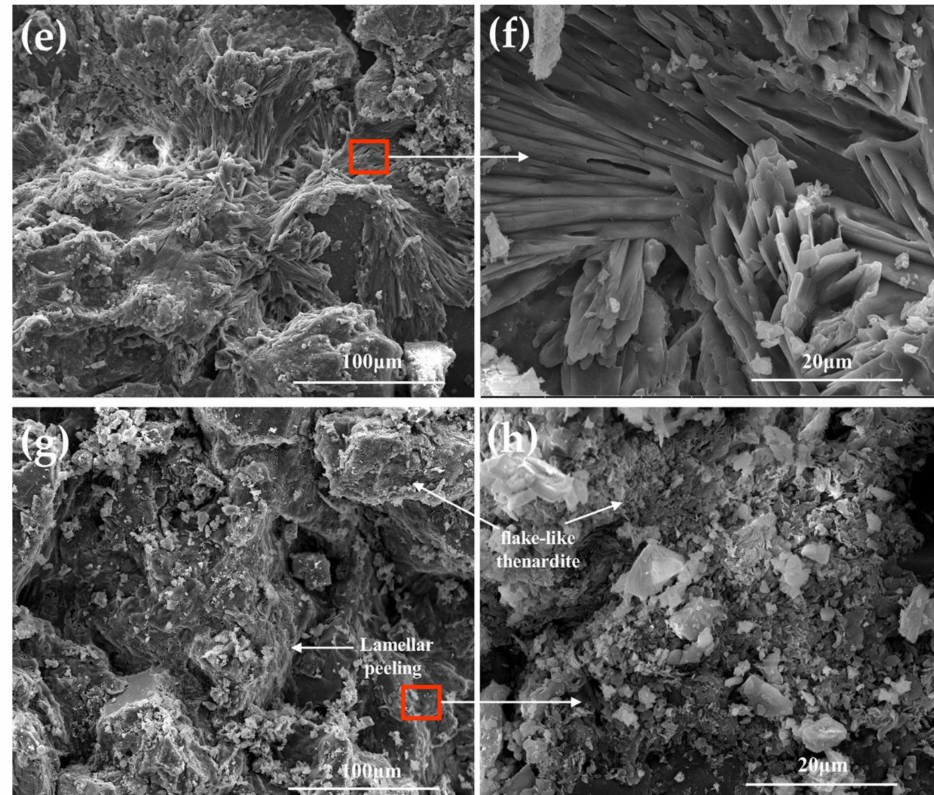
Figure 9. SEM micrographs of sandstone before and after coating with different materials after 13 salt crystallization cycles. ( a , b ) Small − sized thenardite crystals are deposited on the surface of sample SiON. ( c , d ) Prismatic and whisker—like crystals are sequentially deposited on the surface of sample B72. ( e , f ) Abundant dendritic, thenardite crystals grow on the surface of sample PDMS. ( g , h ) Flake—like thenardite crystals deposited on the surface of sample